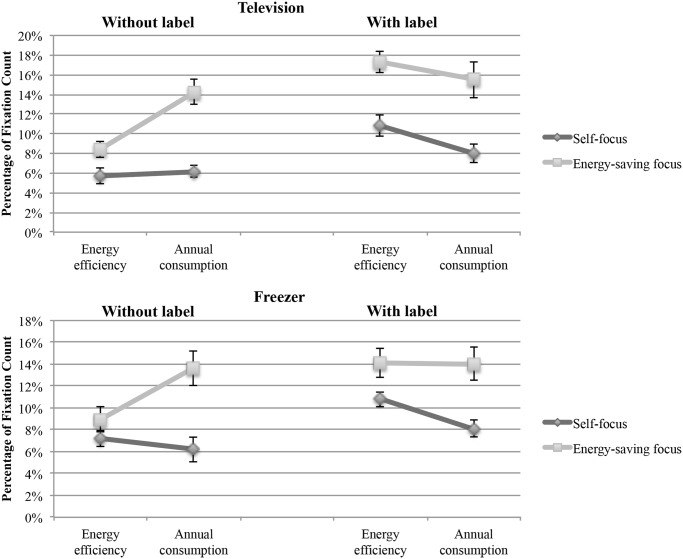
Percentages of fixation count as a function of information format (energy efficiency vs. annual consumption), label (with vs. without label), and focus (self vs. energy saving). The error bars represent the standard error.